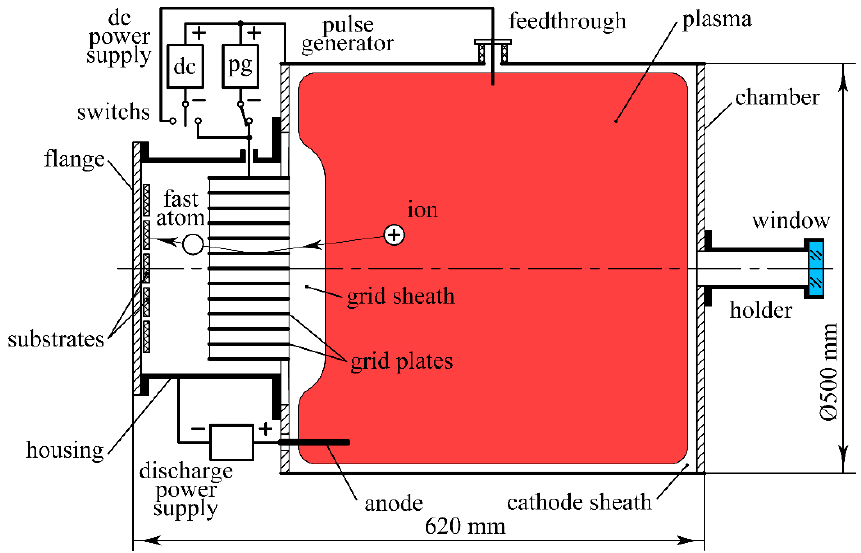
Figure 1. Schematic of an experimental setup for modification of dielectric substrates.